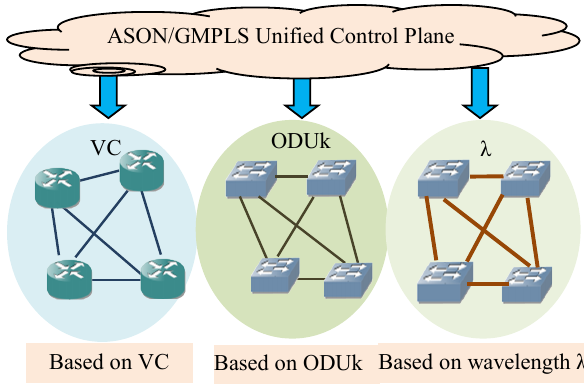
Figure 2. Multi-layer ASON Network Based on